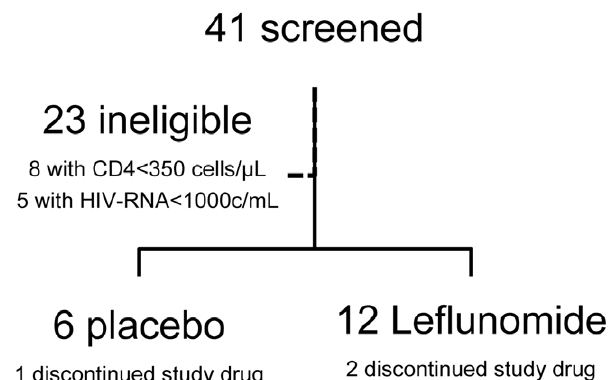
Figure 1. Flow chart of clinical study.